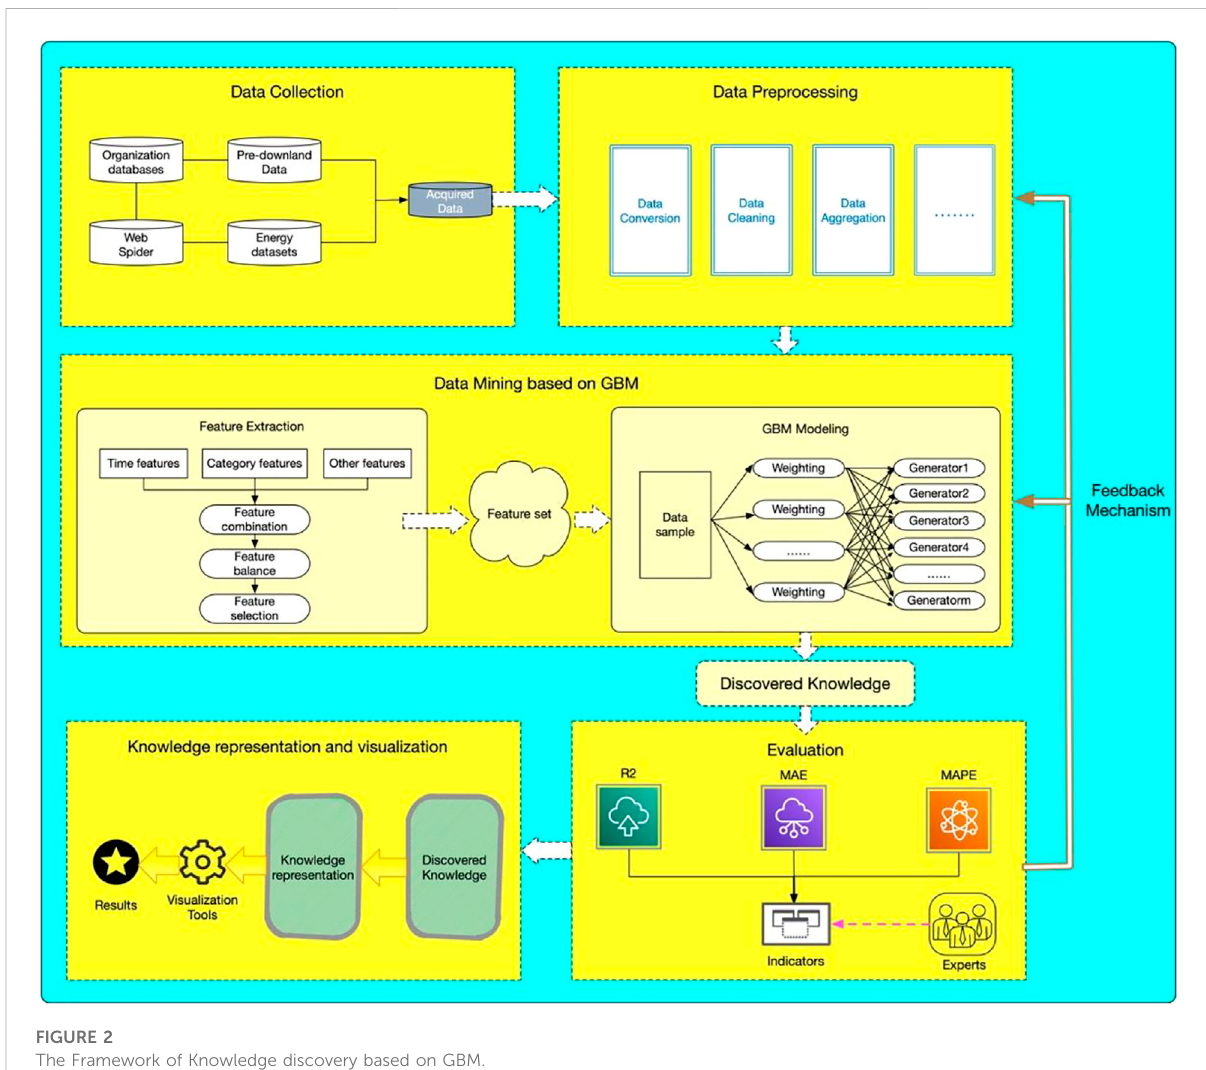
FIGURE 2 The Framework of Knowledge discovery based on